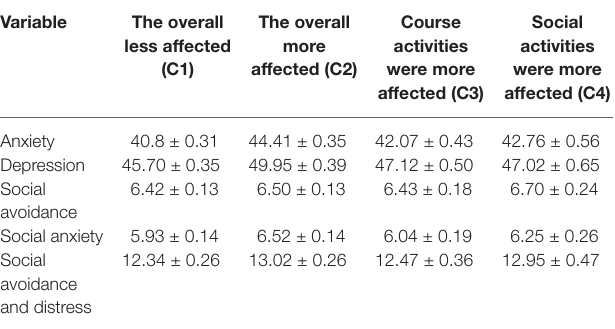
TABLE 5 | Mental health scores of graduate students in various latent